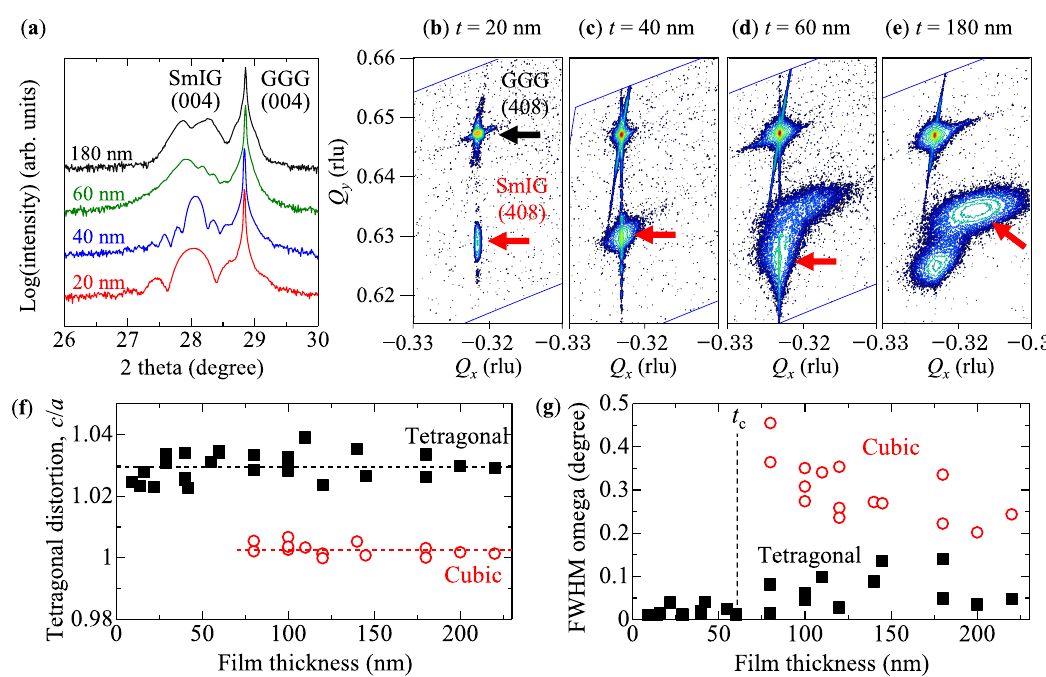
Fig. 1 Structural properties of SmIG fi lms. a 2 θ – ω XRD scans of SmIG fi lms with different fi lm thicknesses on GGG (001) substrates. b - e RSM around (408) substrate peaks for ( b ) 20 nm, ( c ) 40 nm, ( d ) 60 nm, and ( e ) 180 nm-thick SmIG fi lms. Q x and Q y indicate reciprocal lattice vector along (100) and (001), respectively. The rlu indicates reciprocal lattice unit. The black and red arrows denote the peaks from GGG substrates and SmIG fi lms, respectively. f , g Film thickness dependence of ( f ) tetragonal distortion c / a and ( g ) FWHM of omega scans for tetragonal and cubic phases. Closed squares and open circles represent the values for strained tetragonal and relaxed-cubic phases,